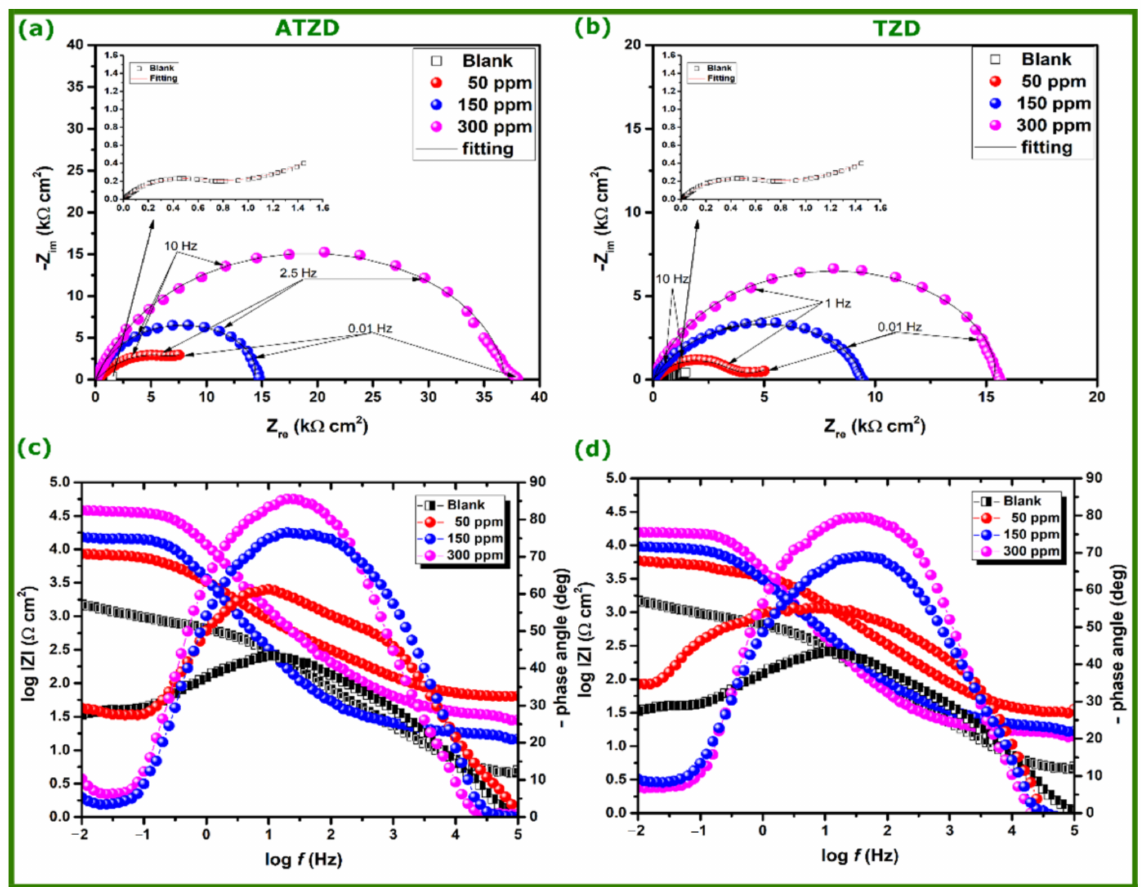
Figure 1. EIS data for copper in 3.5 wt.% NaCl without and with various concentrations of thiazolidinedione derivatives at 298 K; ( a , b ) Nyquist plots, ( c , d ) Bode modulus/Phase angle plots.